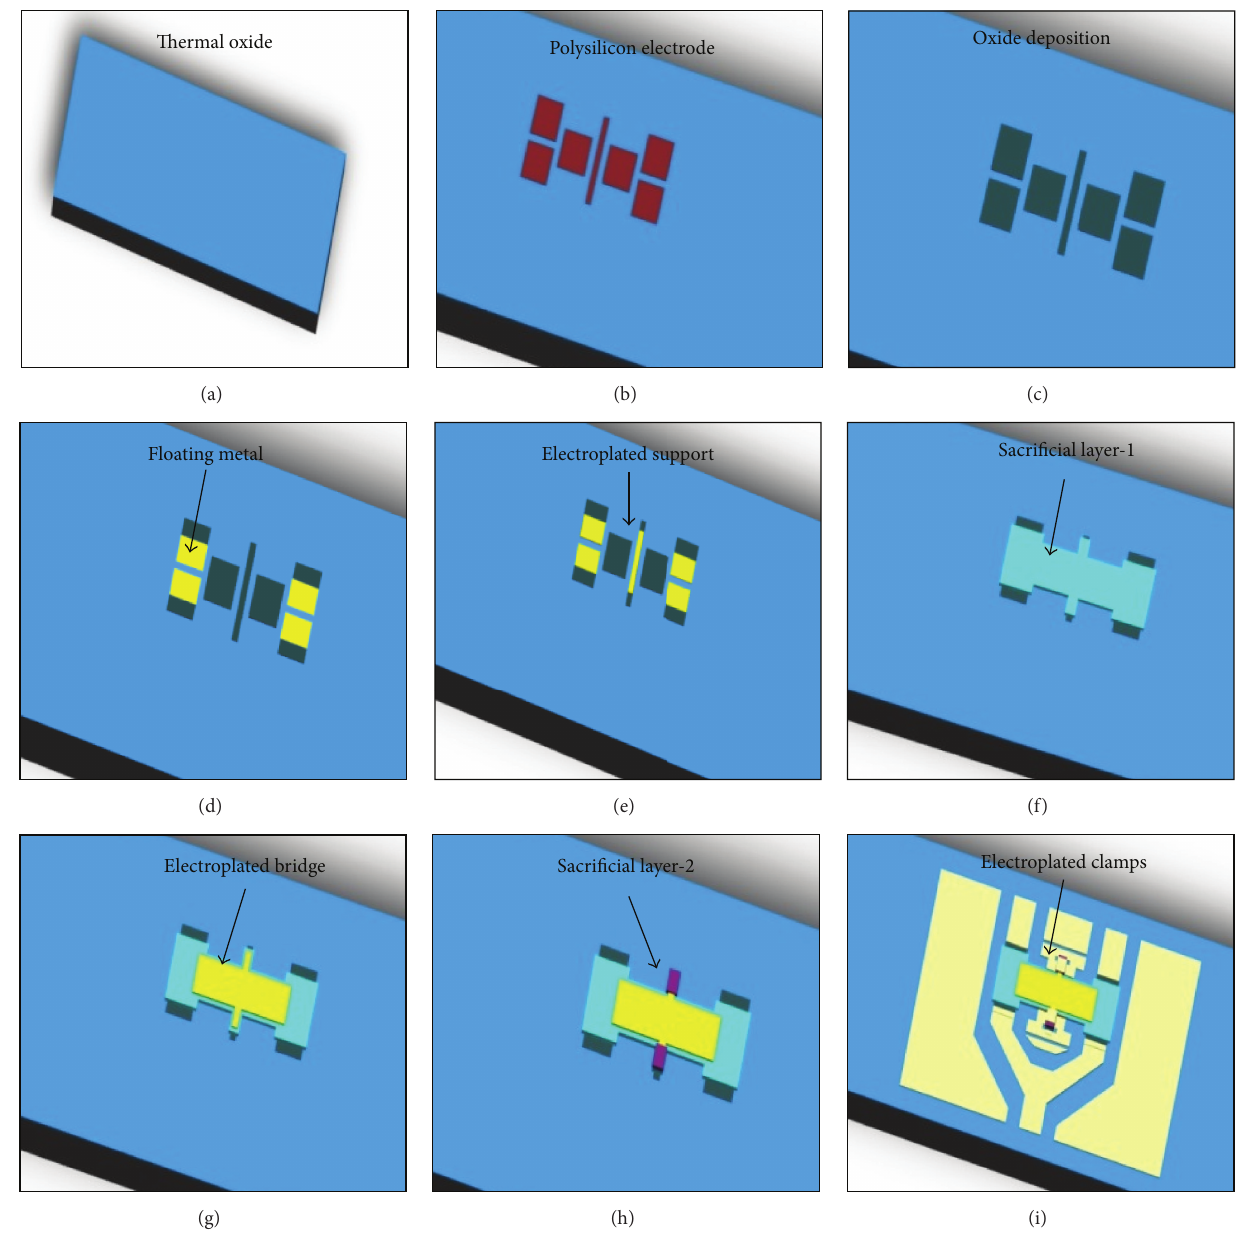
Figure 6: Fabrication process flow for the SPDT